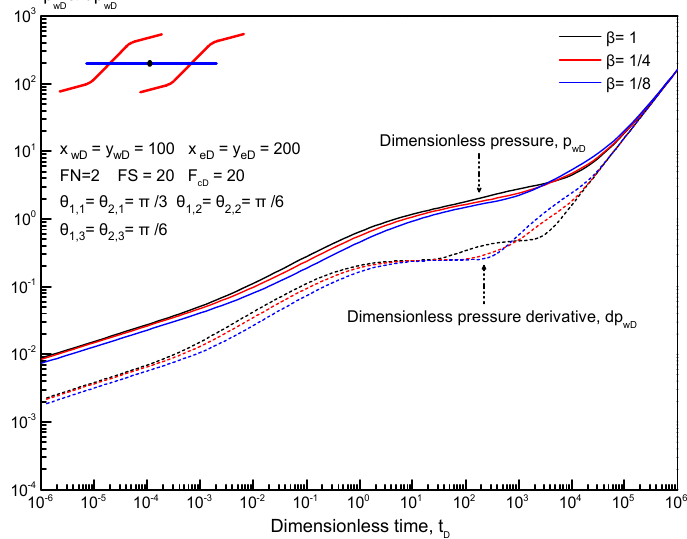
Figure 13. Effect of permeability anisotropy on pressure and the pressure derivative ( β ≥ 1).